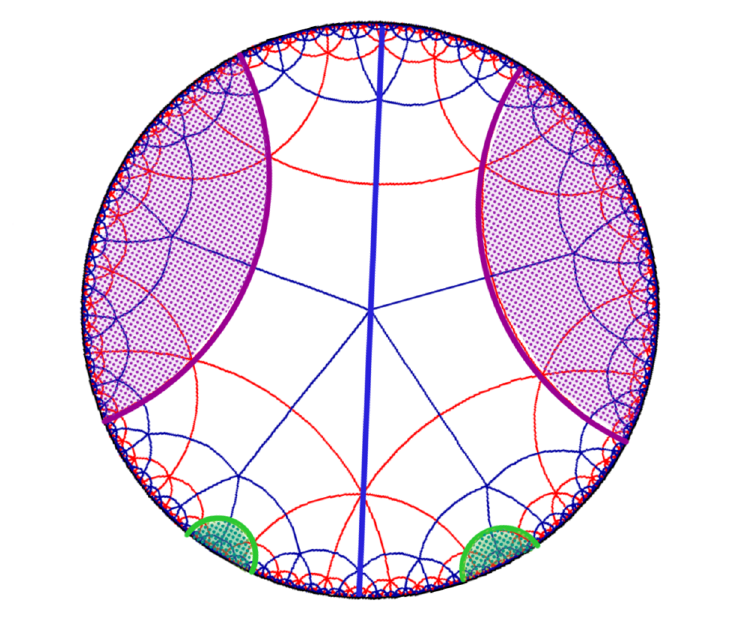
Figure 17. Three-boundary wormhole with